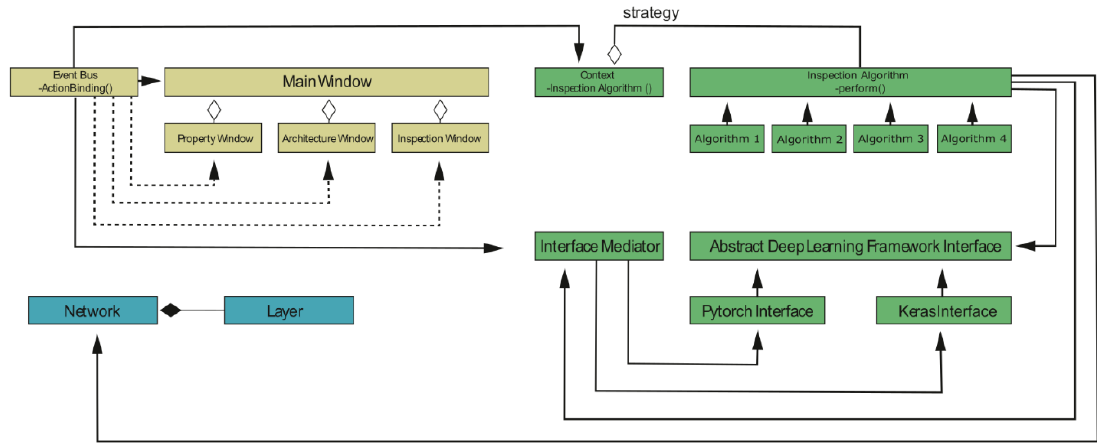
Figure 5. Schematic image of the structure of Neuroscope: model (model), view (yellow), controller (green).